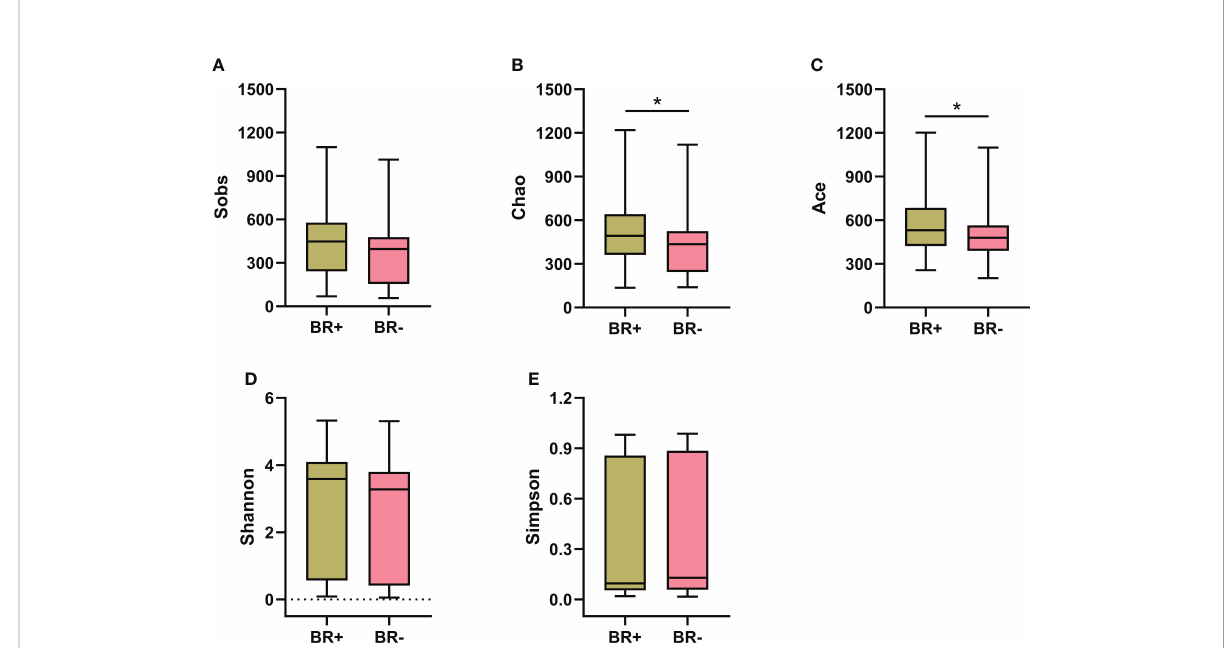
FIGURE 1 Alpha diversity of the gastric microbiota in the BR+ and BR- groups. The Wilcoxon rank-sum test was used to compare the Sobs (A) , Chao1 (B) , Ace (C) , Shannon (D) , and Simpson (E) indices between the two groups. *, P <